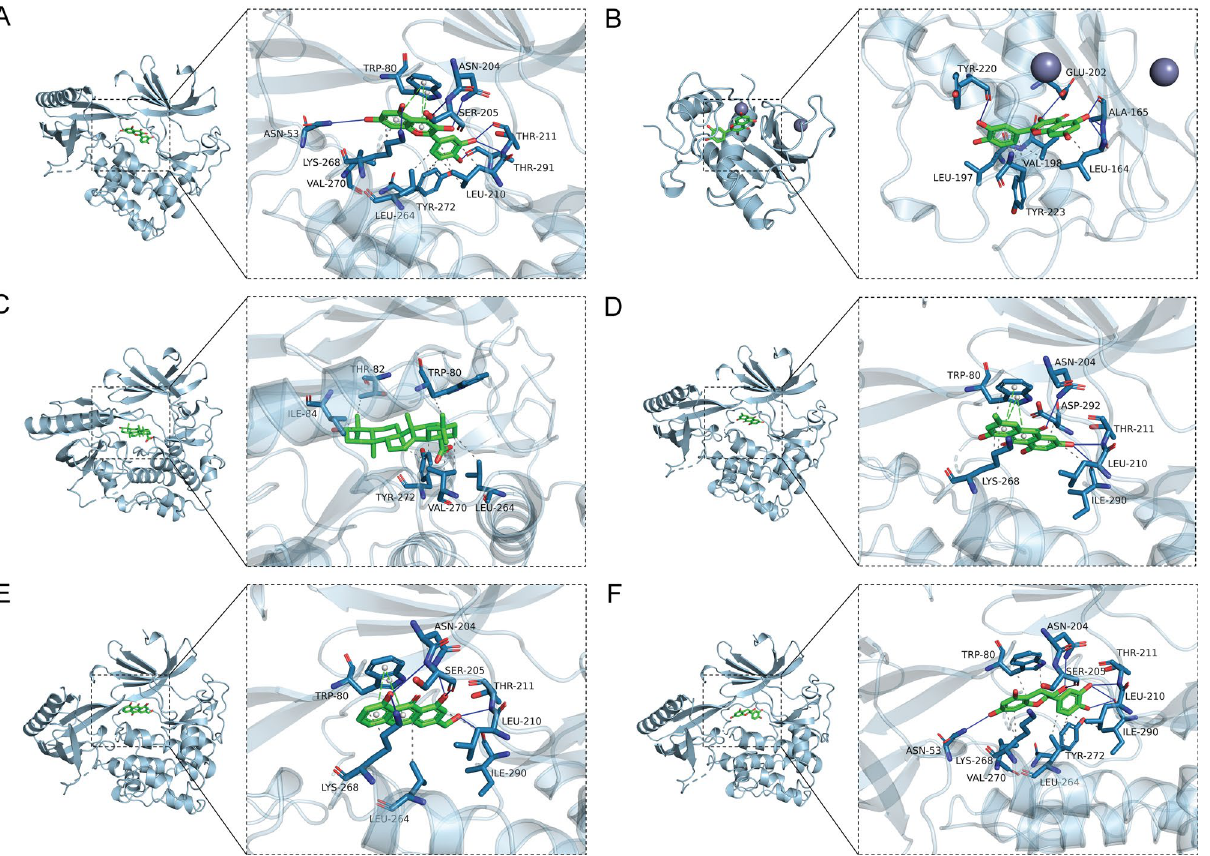
Figure 7. Docking diagram of active ingredient and target. ( A ) docking binding of quercetin-AKT1; ( B ) docking binding of quercetin-MMP3; ( C ) docking binding of oleanolic_acid-AKT1; ( D ) docking binding of emodin-AKT1; ( E ) docking binding of aloe_emodin-AKT1; ( F ) docking binding of catechin-AKT1.